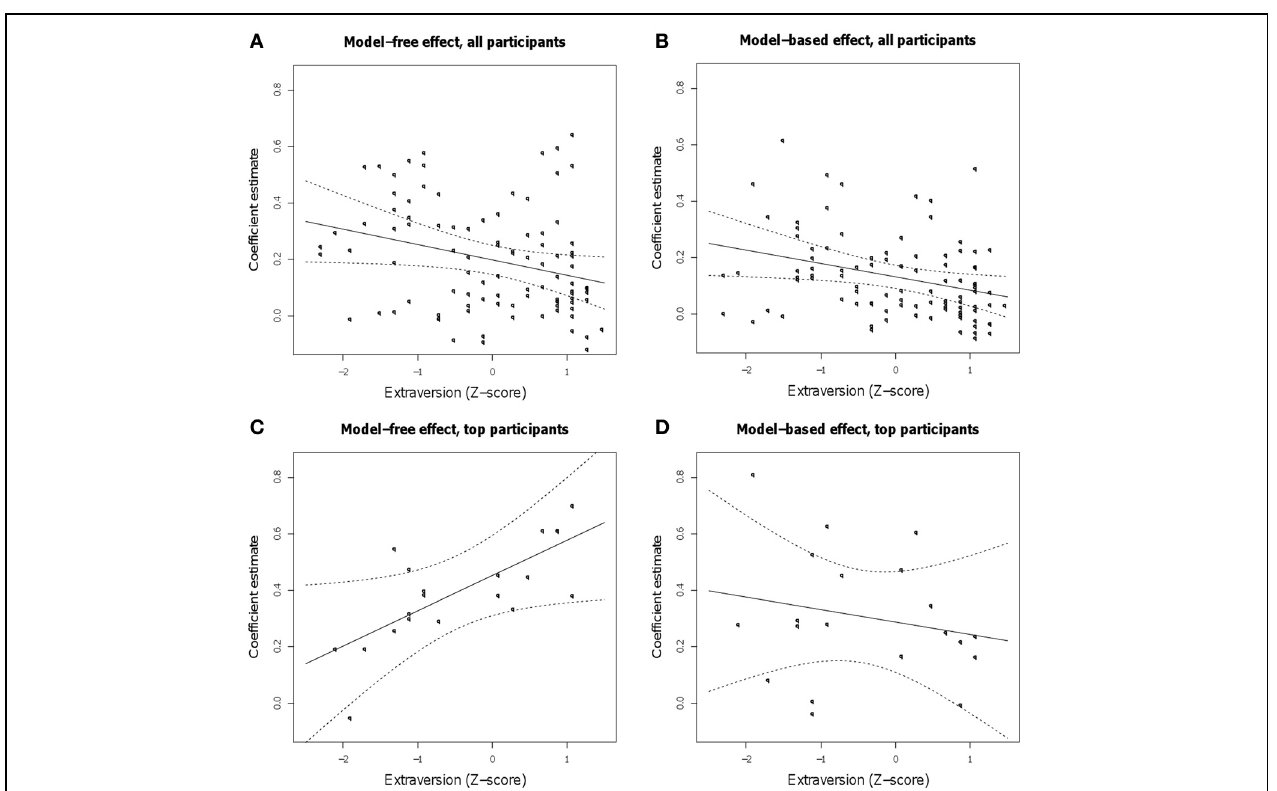
FIGURE 3 | Estimated linear relationship between extraversion and the size of the model-free and model-based learning effects [the regression coefficients for the main effect of reward (A) and its interaction with the transition type (B), respectively] in the full population and in the top